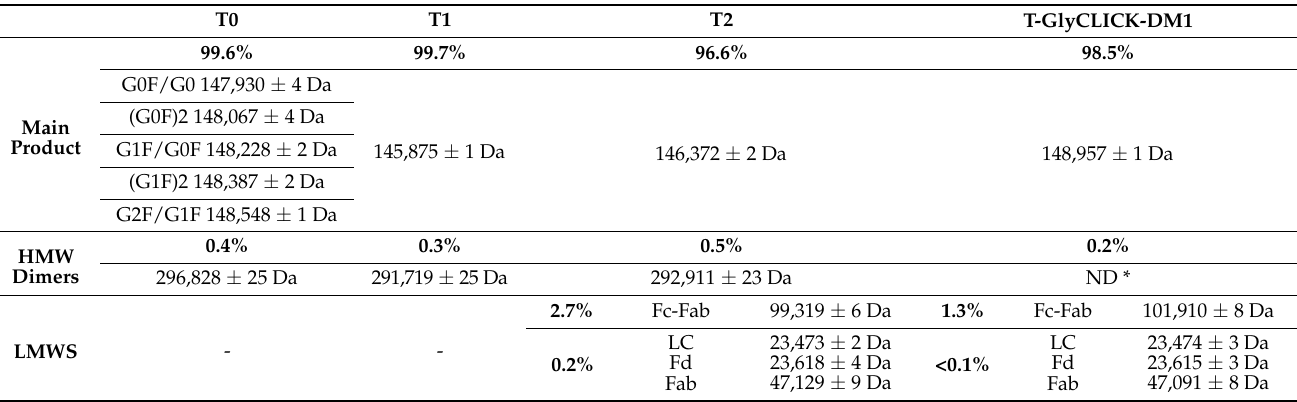
Table 1. Masses of species detected with SEC-nMS. Relative quantification of the different species was assessed based on SEC-UV signals. * ND = mass not determined because of very low intensities on the nMS spectrum. T0 T1